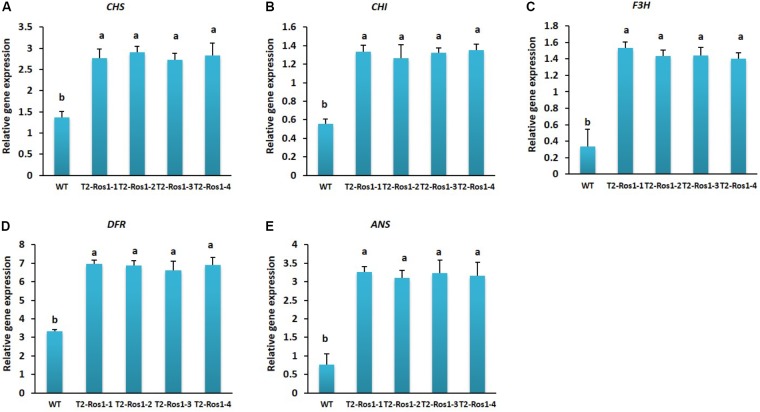
Transcriptional analysis of anthocyanin biosynthetic gene in flowers of WT and four independent T2-Ros1 lines (A–E). NtActin gene was used as reference gene to normalize the transcript levels of the genes. Error bars indicate the SE of means of three replicates. Means with different letters are significantly different (DMRT, p < 0.05).